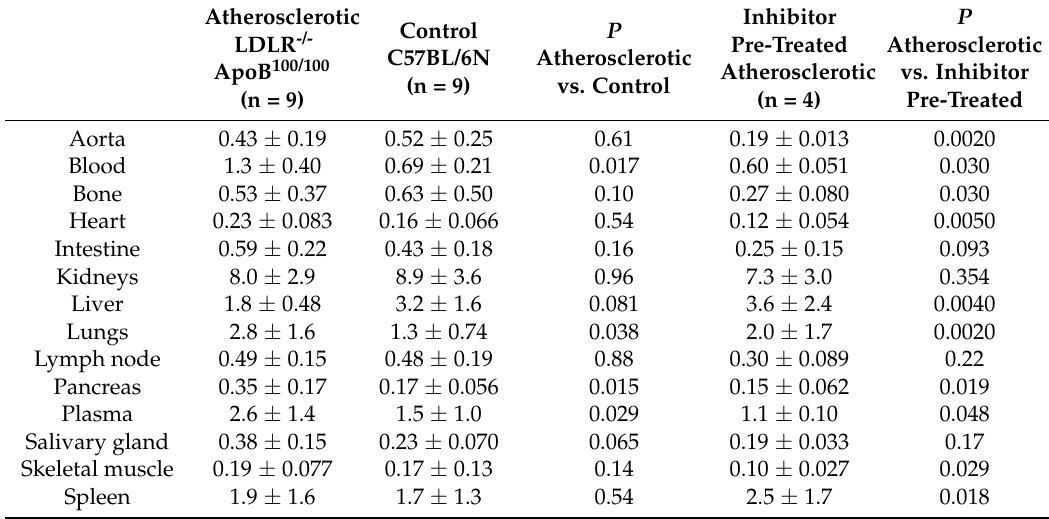
Table 1. Ex vivo biodistribution of MMP-2/9 targeted [ 68 Ga]Ga-DOTA-TCTP-1 in mice at 60 min after intravenous injection.